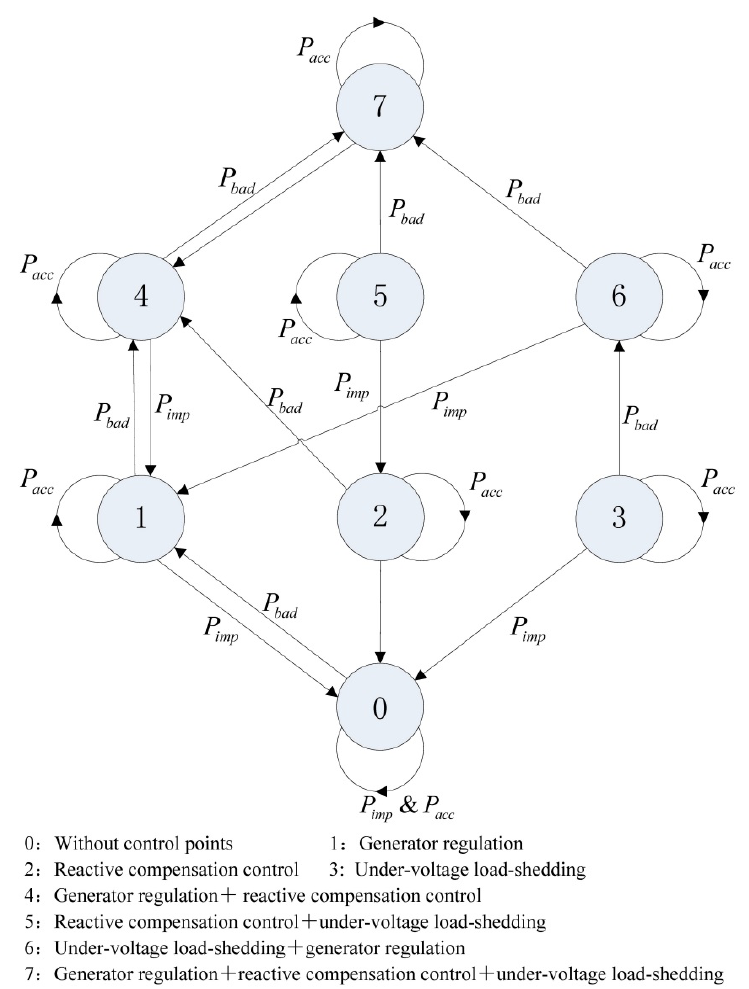
Figure 2. Discrete output function in the top